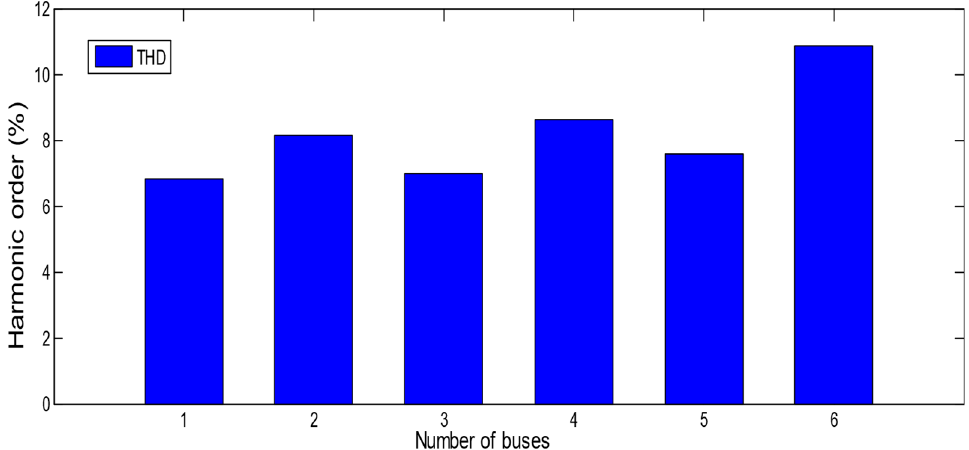
Figure 2. Total harmonic distortion at various buses on a 6-bus test system.